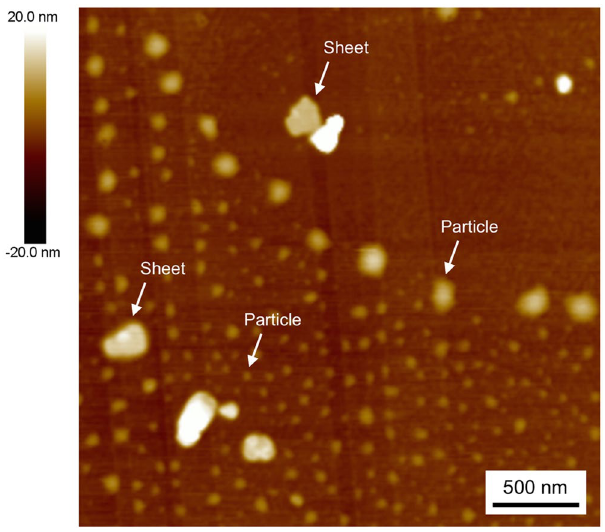
Figure 4. A tapping mode AFM height image of Zn-2 just after preparation in THF/hexane (5:95, vol/vol, 100 μ M); the sample was dispersed by ultrasonication and drop-cast on an HOPG